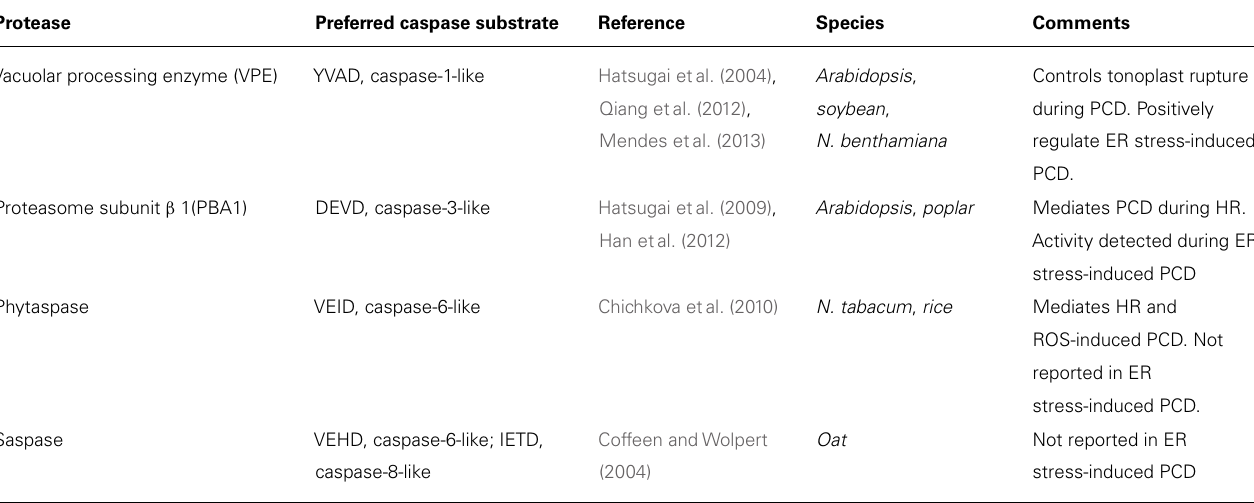
Table 1 | Plant caspase-like activities and ER stress-induced